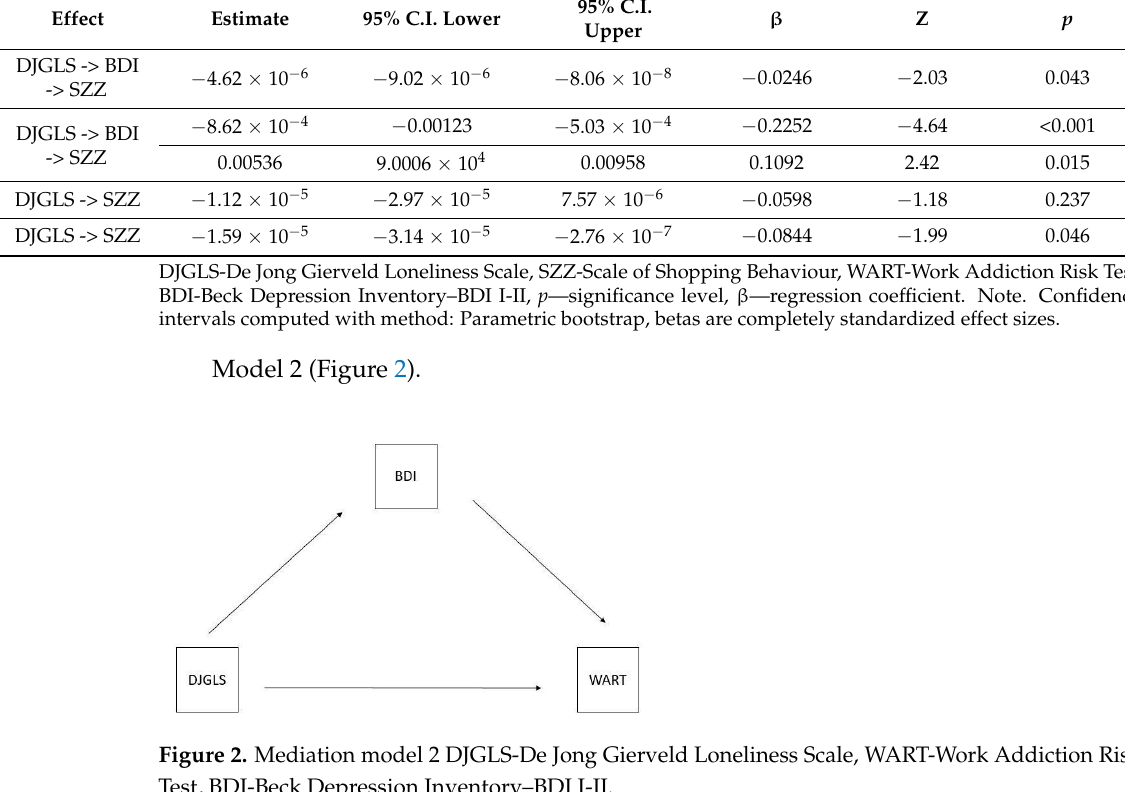
Table 2. Indirect and Total Effects ‐ mediation model 1.